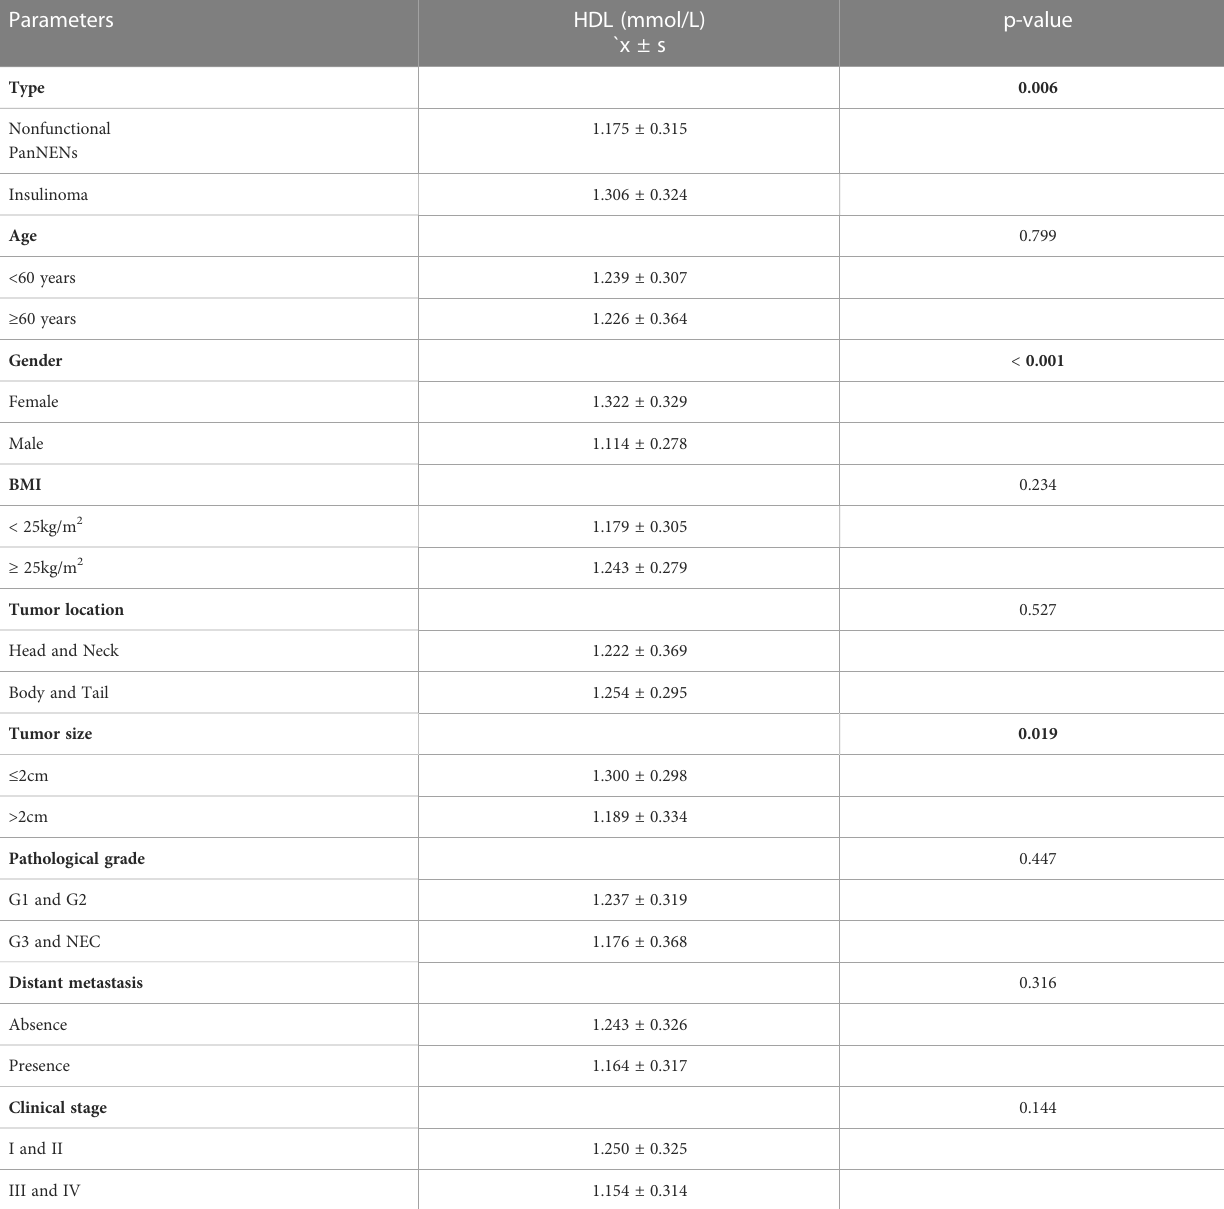
TABLE 4 Comparison of clinicopathologic parameters of HDL